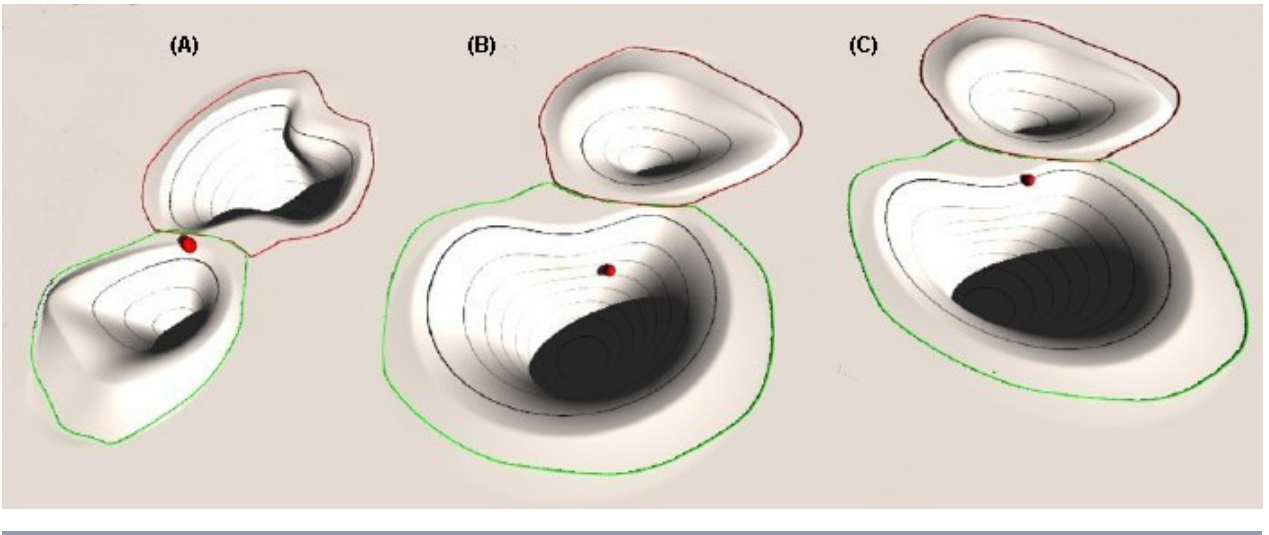
Fig. 3. Stability landscapes representing arid ecosystems in (A) the United States, (B) South Africa, and (C) Madagascar. There are differences in the lower basin of attraction in terms of the precariousness of the current position of the system (location of the red dot) and basin’s latitude. Resistance is the same in all three